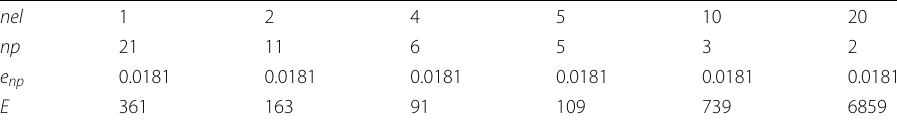
Fig. 13 An advective–diffusive problem with constant source. DNS solutions at times 0.25 s, 0.5 s, 0.75 s, and 1.5 s are compared with P-DNS solution on the np points Table 1 An advective–diffusive problem with constant source